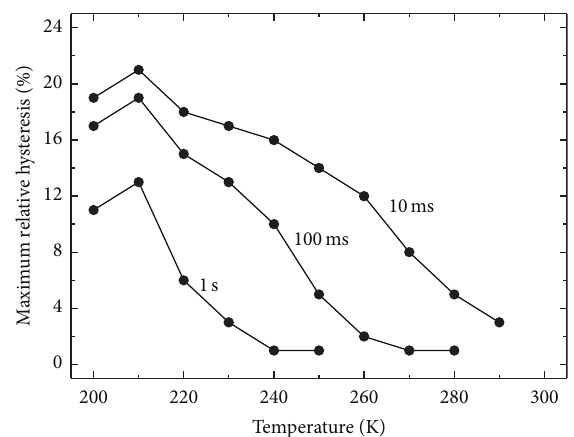
Figure 4: Relative hysteresis opening (with respect to the upper curve in Figure 3) for the three sweep times at different tempera- tures.